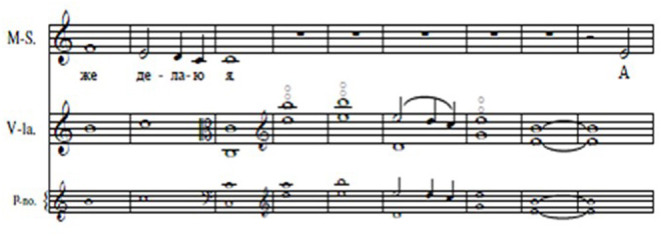
“Homer” bars 29–37.